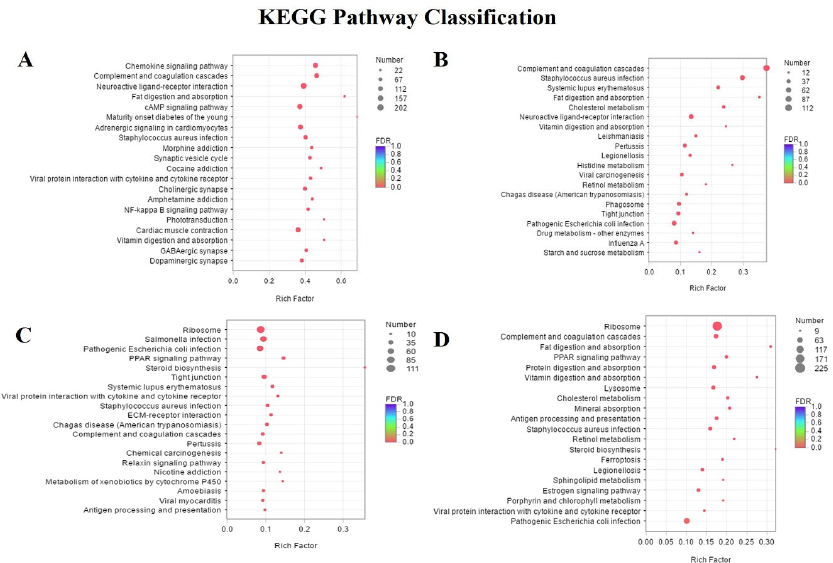
Figure 8. Bubble diagram of pathways in which DEGs are predicted to participate in hybrid triploid loaches at ( A ) 4 dph, ( B ) 15 dph, ( C ) 22 dph, and ( D ) 50 dph.